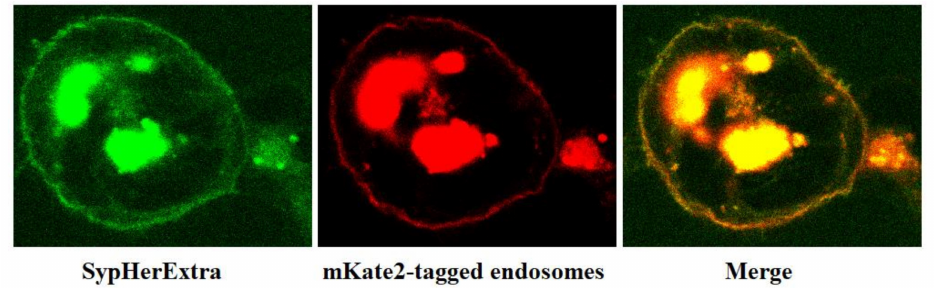
Figure 2. Fluorescent images of the fixed HEK293 cells expressing extracellular membrane-anchored SypHerExtra sensor ( left ) and mKate2 fluorescent protein targeted to endosomes ( center ). The merged image ( right ) indicates SypHerExtra colocalizated in endosomes.